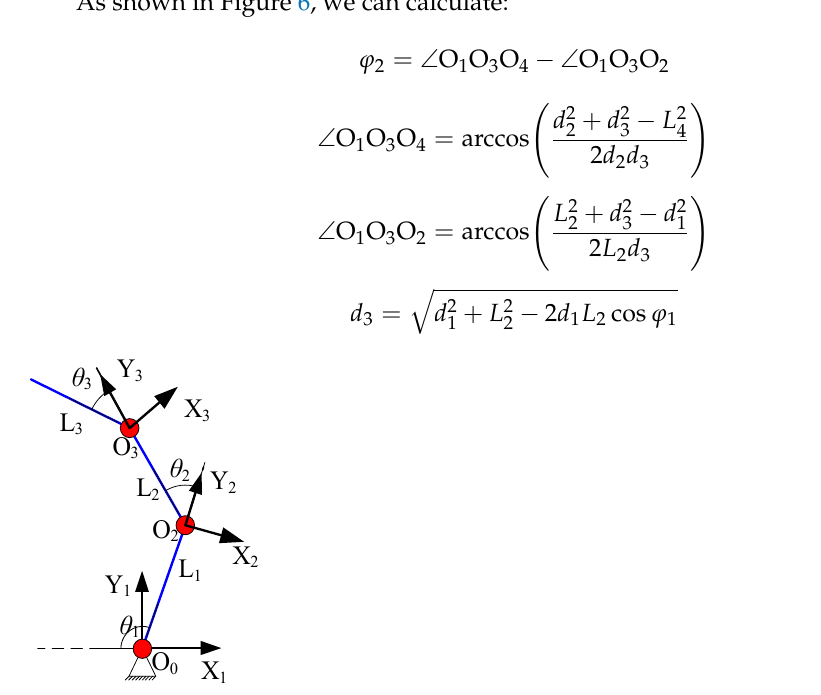
process, and vice versa for the releasing process (Figure 5b).